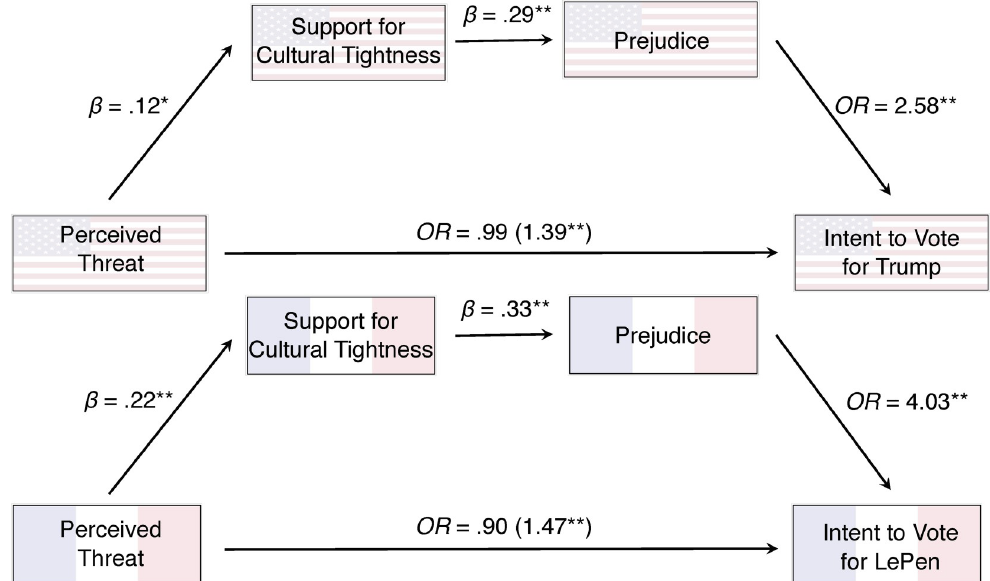
Fig 5. A serial mediation path model showing the effects of threat on intention to vote for Donald Trump (above) and Marine LePen (below) via support for cultural tightness and prejudice. All effects have been standardized so they can be interpreted as effect sizes. Single-starred associations are significant at the p < .05 level; double-starred associations are significant at the p < .005 level. The X-Y path inside the parentheses is the total effect, whereas the effect outside parentheses is the direct